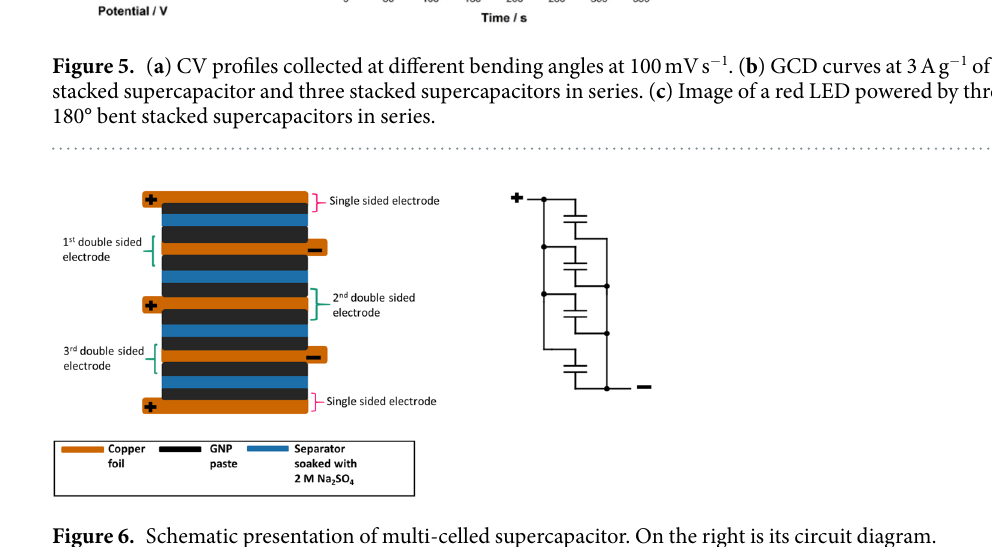
Figure 6. Schematic presentation of multi-celled supercapacitor. On the right is its circuit